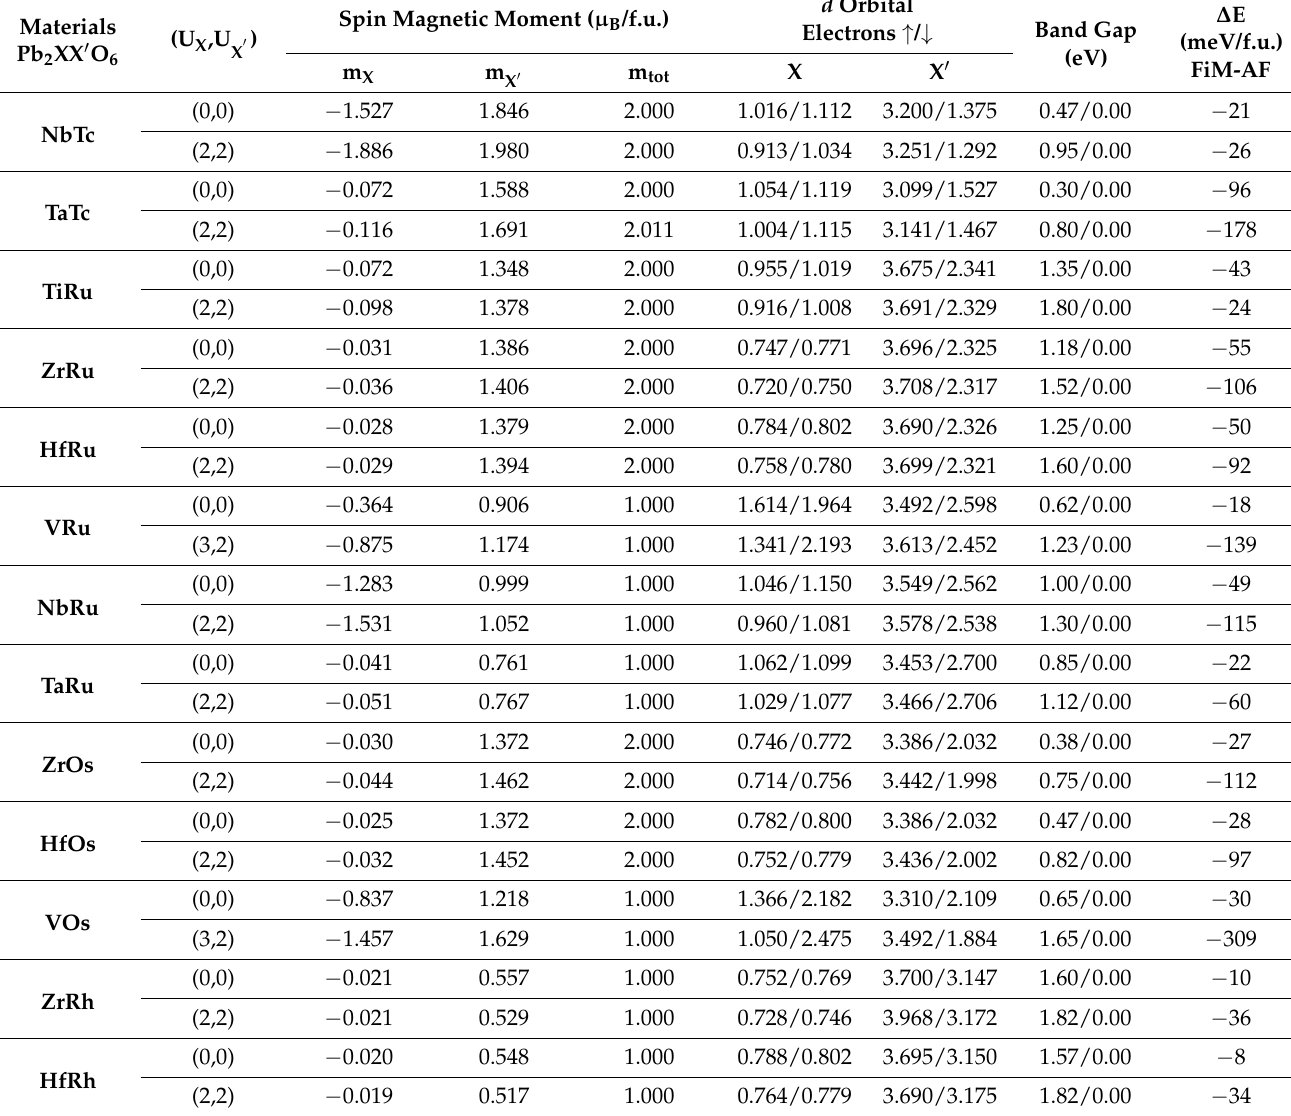
Table 1. Physical properties of the selected FiM-HM family of Pb 2 XX (cid:48) O 6 (X = IVB/VB X (cid:48) = Rh, Hf, Os and Tc) in double perovskite structure by GGA and GGA + U calculations. The parenthesis behind U presents the on-site coulomb parameters: 3 eV for U V , and 2 eV for U IVB , U Nb , U Ta , U Rh , U Hf , U Os and U Tc . (0,0) denotes the absence of GGA + U calculations. ∆ E refers to the energy difference between FiM and AF states. The spin magnetic moments for X, X (cid:48) and the total moment are listed in the table as m X , m X (cid:48) and m tot , respectively. The number of electrons in the spin-up and spin-down orbitals is recorded for X(X (cid:48) )